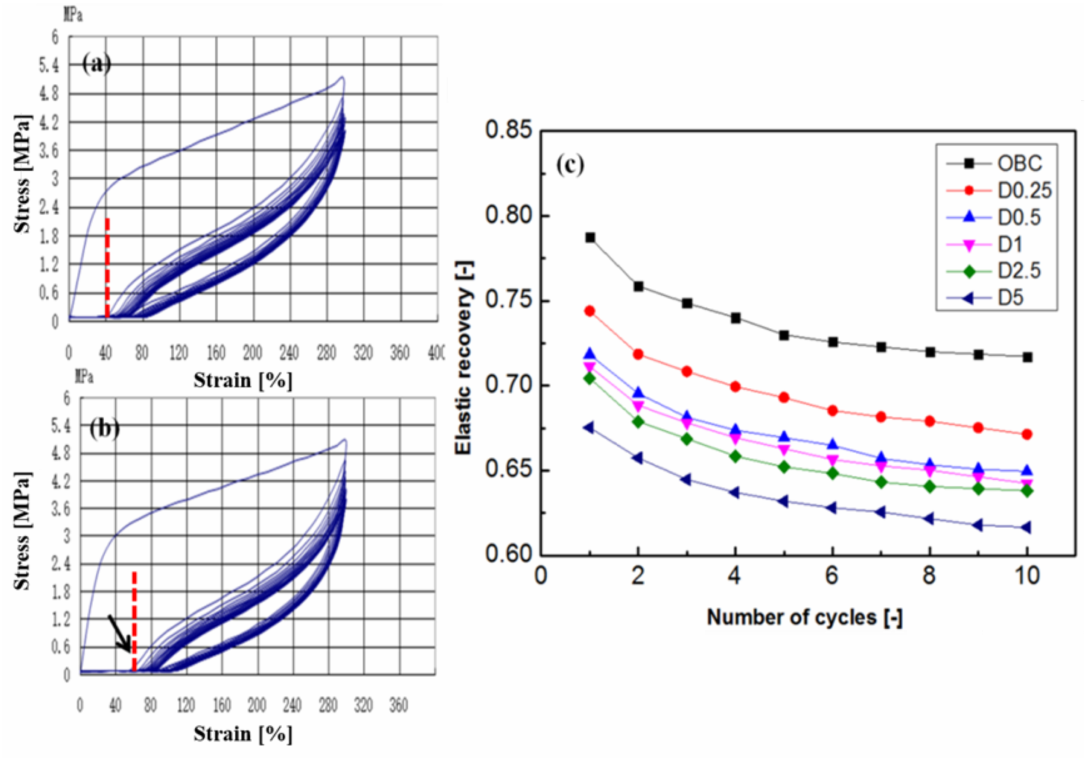
Figure 8. Representative cyclic stress-strain curves for OBC/DMDBS composites ( a ) neat OBC; and ( b ) OBC-D5; and ( c ) elastic recovery as a function of number of cycles for OBC/DMDBS with different contents of